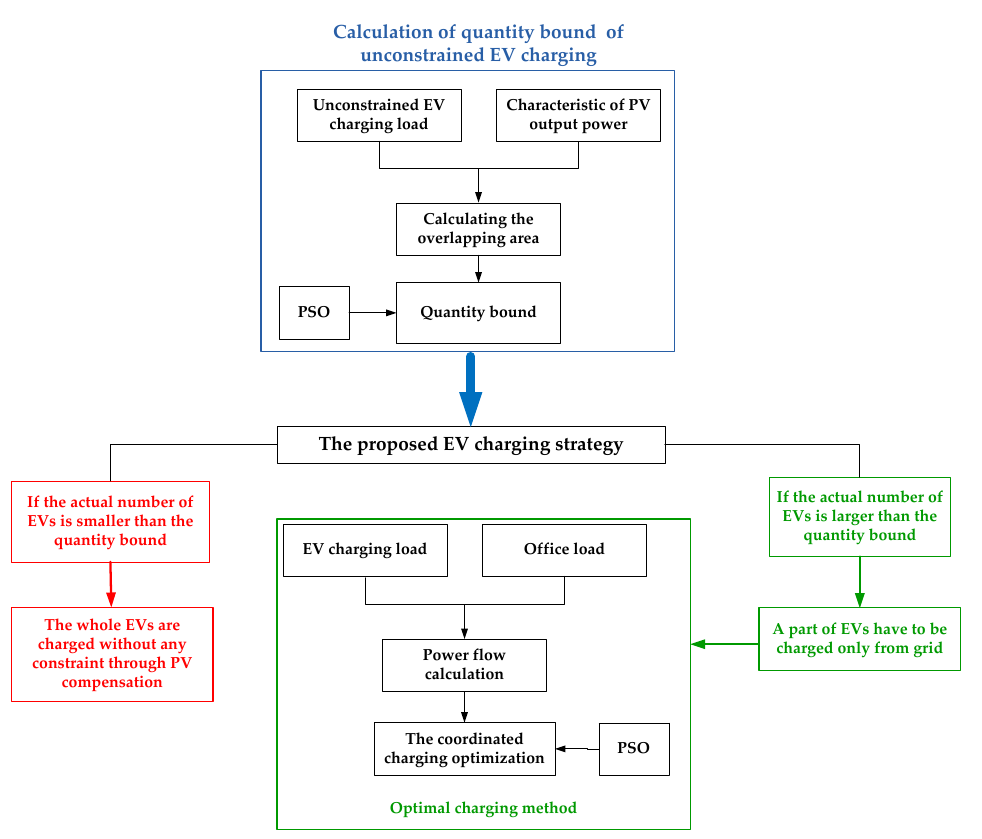
Figure 3. Outline of proposed EV charging strategy in this paper.